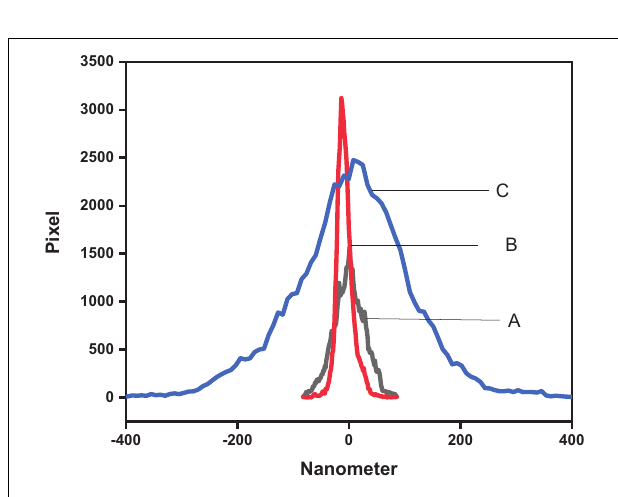
FIGURE 8 | Height distribution of (A) GO, (B) PANI/GO composite, (C) EDTA modified PANI/GO composite.